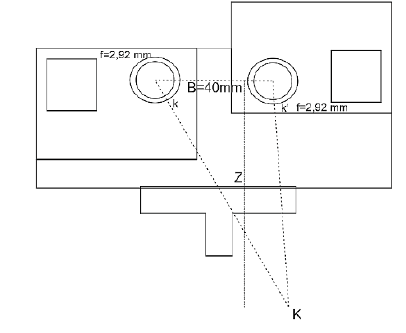
Figure 1. The layout of two imaging cameras (B- Longitudinal base, f-focal length, Z-distance from the point, K- point in space, k; k'- the projection of point K